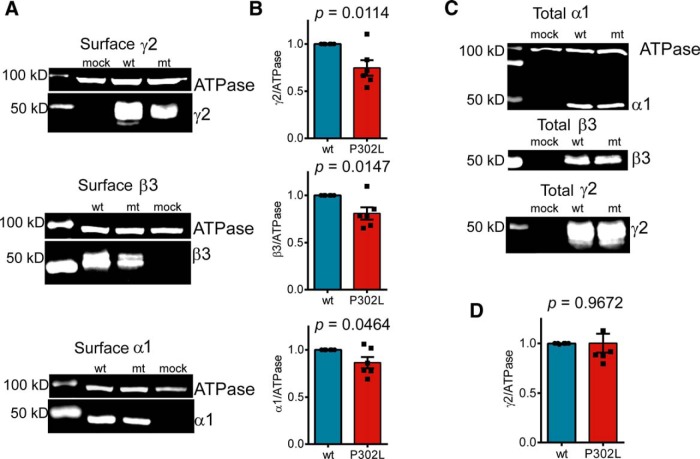
The γ2(P302L) subunit mutation causes slight changes in surface levels of GABAA receptor subunits. A, Wild-type (wt) γ2L or mutant (mt) γ2L(P302L) subunits were coexpressed with α1β3 subunits in HEK293T cells. Surface protein samples were biotinylated, isolated, separated by SDS-PAGE, and probed by anti-GABAA receptor subunit and anti-ATPase antibodies. B, Band intensities of the γ2, β3, and α1 subunits were normalized to the ATPase signal, and the summarized data were shown in the bar graphs. C, Wild-type (wt) or mutant (mt) γ2L(P302L) subunits were cotransfected with α1β3 subunits into HEK293T cells, and total cell lysates were collected, analyzed by SDS-PAGE, and blotted by anti-α1, anti-β3, or anti-γ2 subunit and anti-ATPase antibodies. D, Band intensity of γ2L subunits was normalized to the ATPase signal. Values were expressed as mean ± SEM. An unpaired t test was used to determine significance.